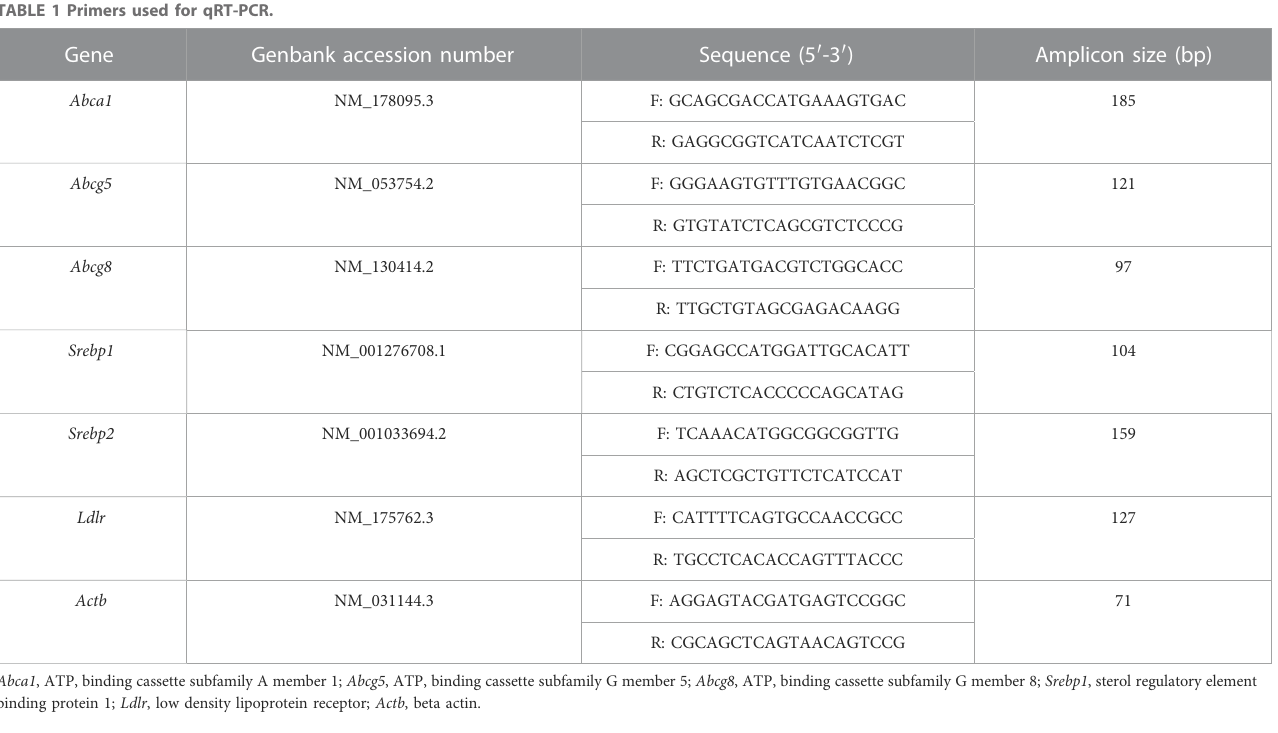
TABLE 1 Primers used for qRT-PCR.